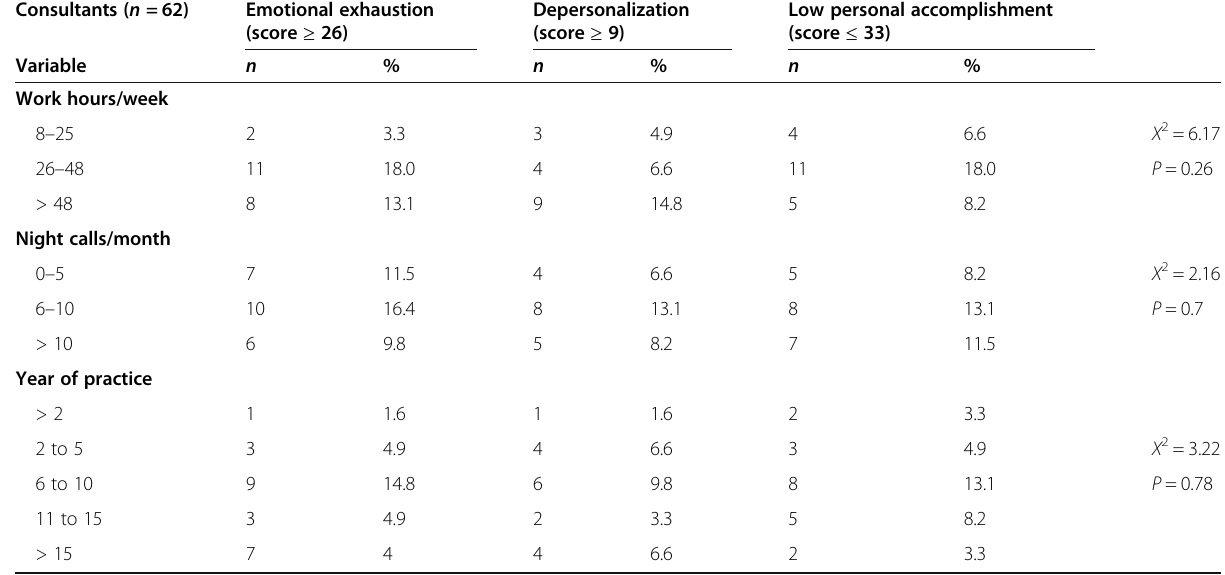
Table 3 Consultants ’ professional characteristics and high burnout scores